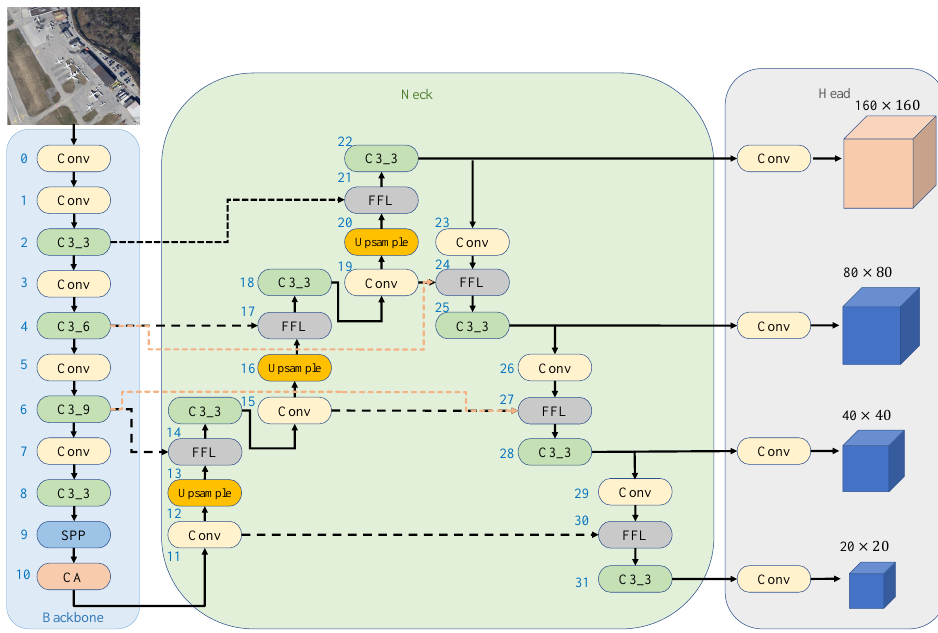
Figure 8. The framework of the improved object detection module.